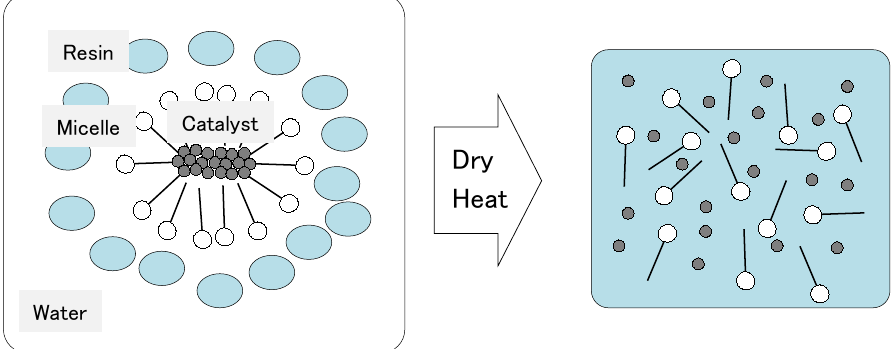
Figure 1. A catalyst encapsulated in a micelle in surfactant solution.